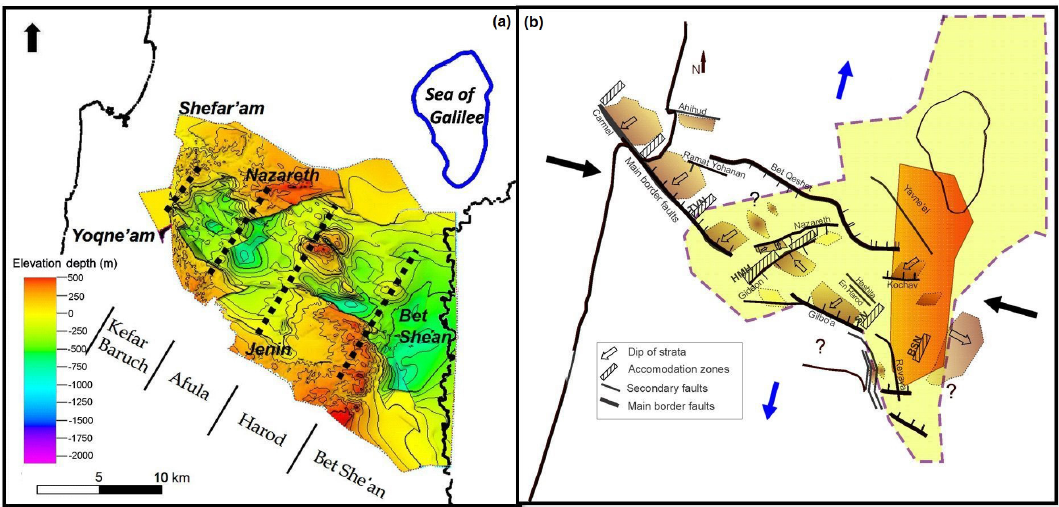
Figure 12. Structure of the study area during the Cenozoic. (a) Structural map of the top Avedat Group. Dashed lines portray the structural highs (H1–4 in Fig. 3a). The current structure of the Galilee is a product of two main subsidence phases shown in (b) . (b) Aerial extent of the first subsidence stage (20–9Ma) is outlined in light yellow. Dark orange – pronounced subsidence during the first stage, overlapping the current Dead Sea fault valley. The second subsidence stage (9–5Ma) is outlined by a series of NNE-trending basins perpendicular to the major axis of basins from the first stage. Darker brown – pronounced subsidence. The second-stage stress field is depicted by black arrows (compression) and blue arrows (extension). Bounding normal faults also exhibit a lateral component. HMH – Hayogev-Mizra high, TVN – Tiv’on, SN – Sede Nahum, BSN – Bet